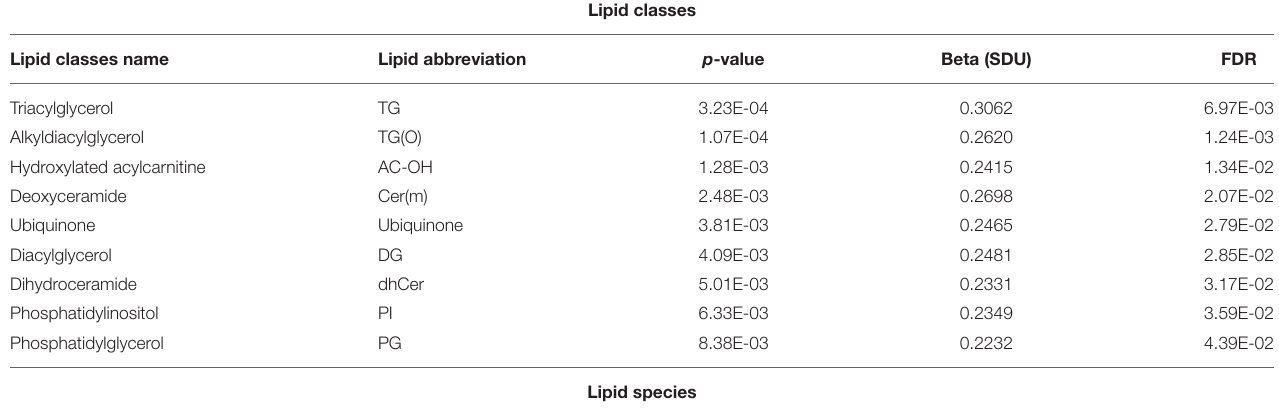
TABLE 3 | Species and classes of lipid with the lowest false discovery rate p- values in our study.